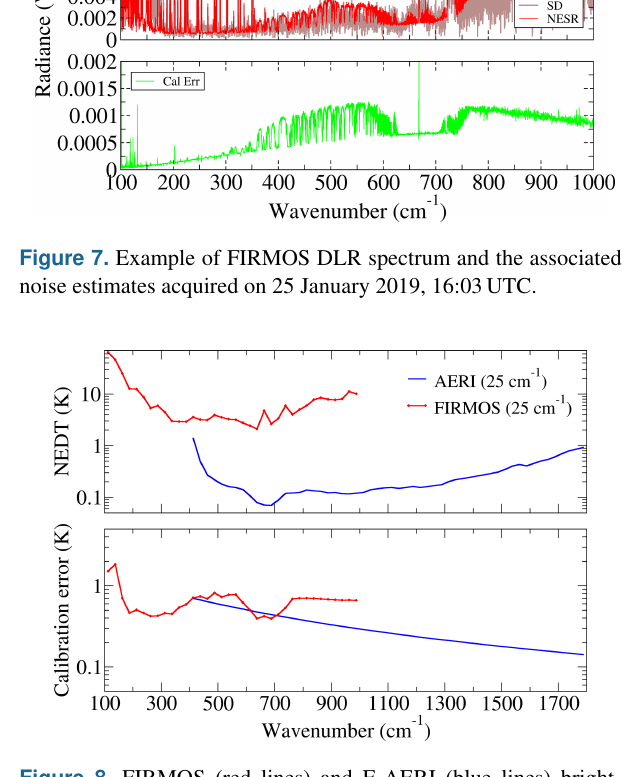
Figure 8. FIRMOS (red lines) and E-AERI (blue lines) bright- ness temperature error estimates at 280K, averaged over 25cm − 1 wavenumber bins across the spectrum.